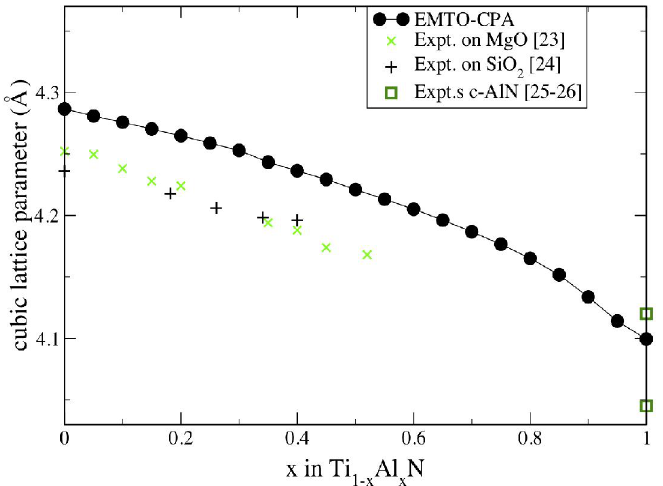
Figure 2. The lattice parameter of Ti obtained from EMTO-CPA calculations (filled circles) [15]. The experimental results from references [23-26] are shown for